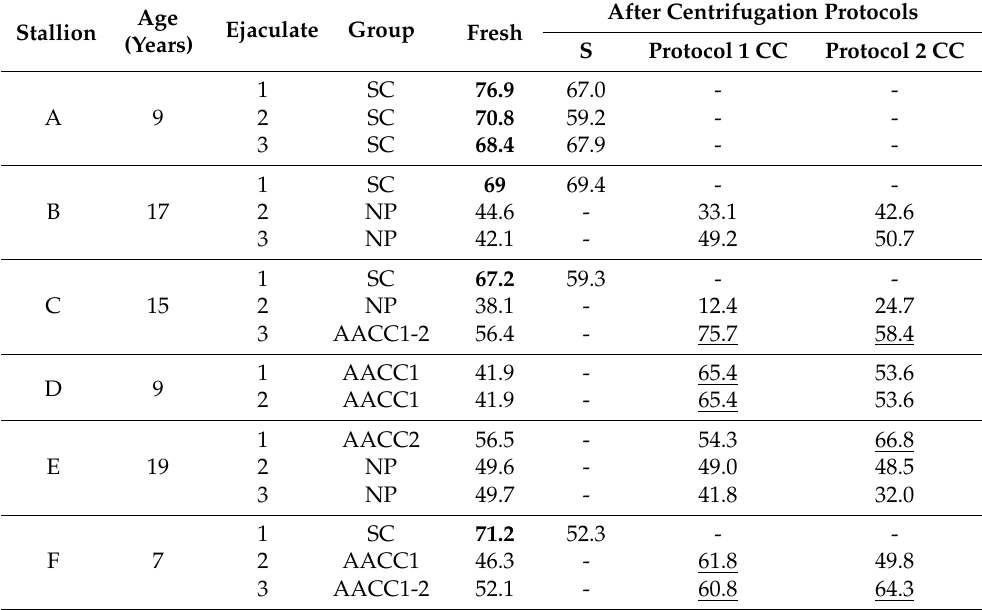
Table 1. Progressive motility values for fresh semen and after centrifugation protocols. Age Ejaculate Group Fresh Stallion (Years)